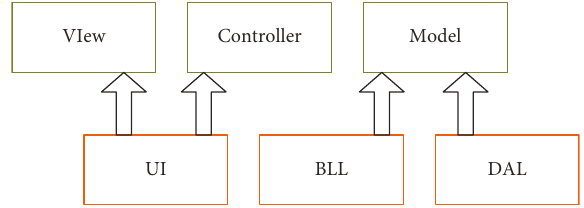
Figure 4: Differences and connections between a three-tier ar- chitecture and an MVC design